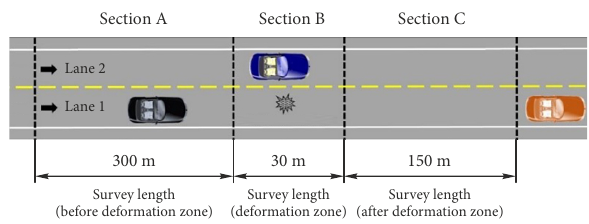
Figure 2. DZ on a two-lane highway